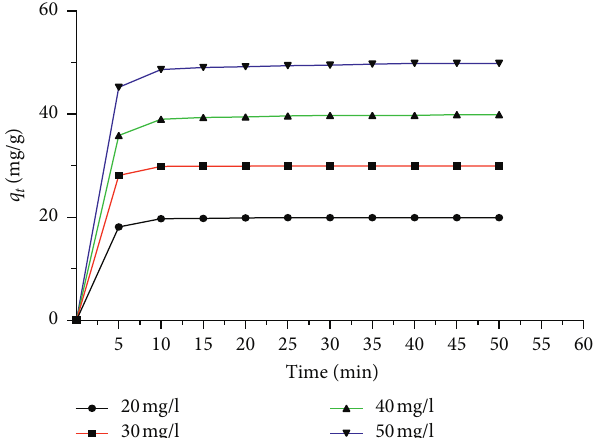
Figure 5: Effect of contact time and the initial concentration of BG on the adsorption capacities of ASP. Interval of initial concentration: 20–50mg/L, pH: 6.8, adsorbent amount: W : 0.2 g, V : 200mL, and T : 25 ° C.